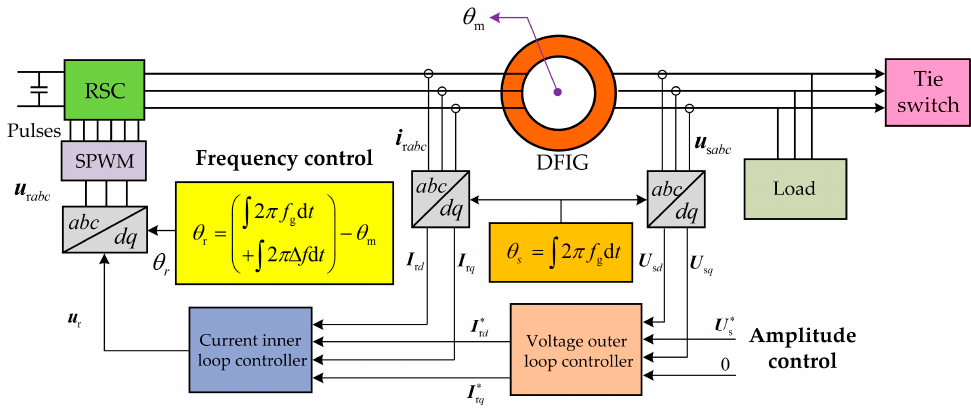
Figure 3. DFIG islanding active synchronization control technology.